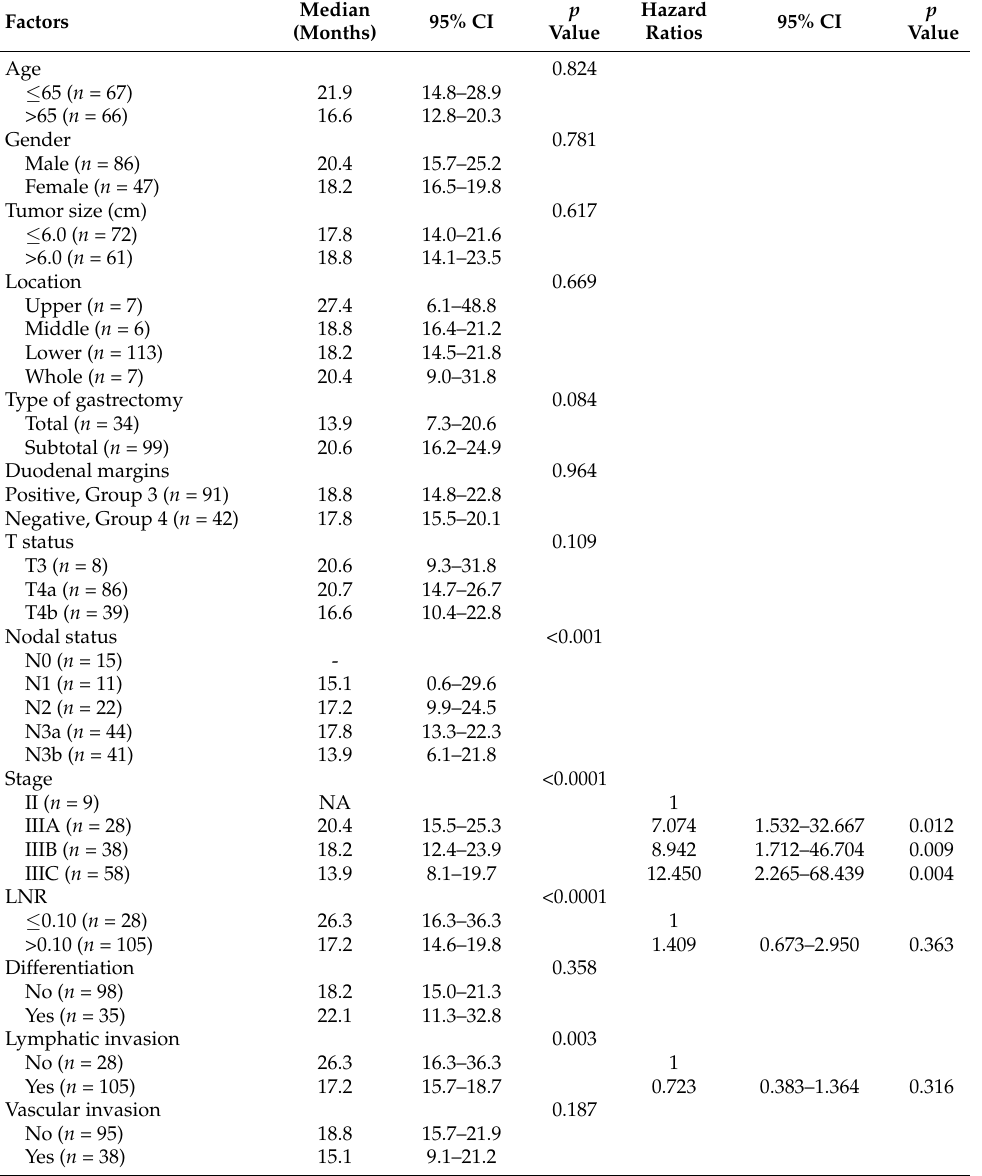
Table 6. Univariate and multivariate analysis of prognostic factors for overall survival in group 3 and 4